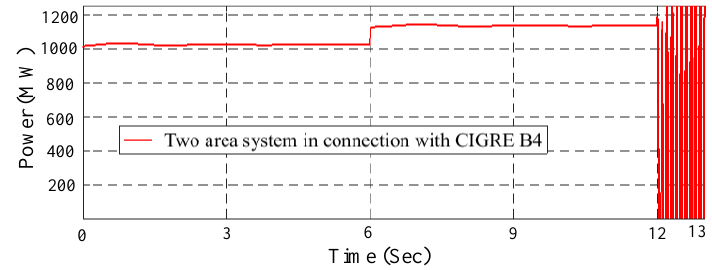
Table 7. Load flow results at transmission limits of Standalone Kunder’s network and Interconnected AC/DC grid.